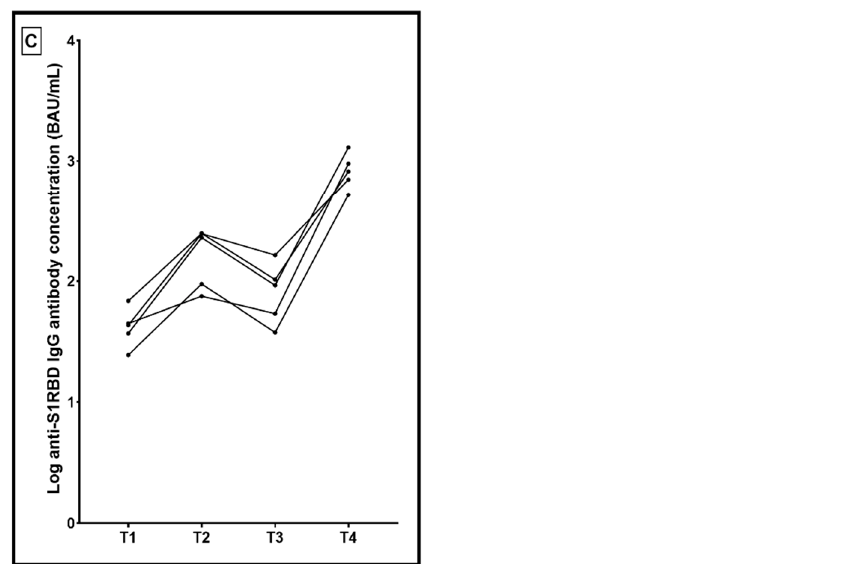
Figure 3. ( A ) Correlation graph representing the change in anti-S1RBD IgG antibody concentrations in participants vaccinated with three doses of BNT162b2 (PfVac-Pf) across four time points; 3 weeks after the first vaccination dose (T1), 3 weeks after the second dose (T2), 3 months after the second dose (T3), and 3 months after the booster dose. ( B ) Correlation graph representing the change in anti-S1RBD IgG antibody concentrations in participants vaccinated with three doses of ChAdOx1-S (AzVac-Az) across four time points; 12 weeks after the first vaccination dose (T1), 3 weeks after the second dose (T2), 3 months after the second dose (T3), and 3 months after the booster dose. ( C ) Correlation graph representing the change in anti-S1RBD IgG antibody concentrations in partic- ipants vaccinated with two doses of ChAdOx1-S and one dose of mRNA-1273 (AzVac-Md) across four time points; 12 weeks after the first vaccination dose (T1), 3 weeks after the second dose (T2), 3 months after the second dose (T3), and 3 months after the booster dose. **** p <